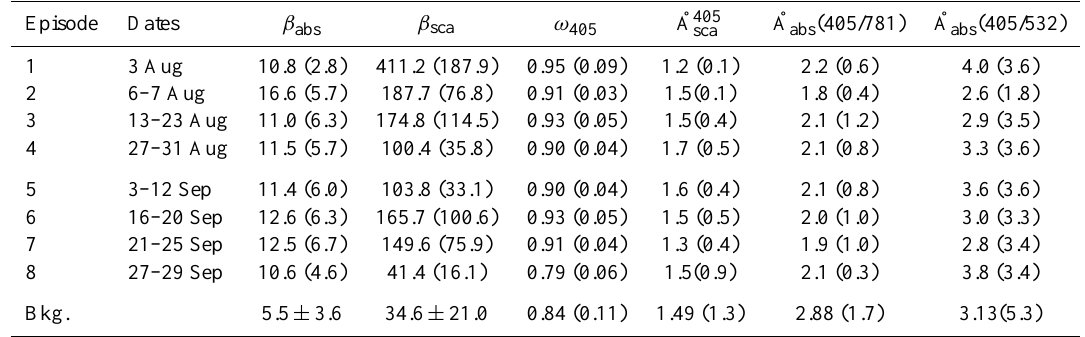
Table 1. Aerosol absorption and scattering coefficients at 405nm, ω 405 , ˚A 405 sca , ˚Angstrom exponents of absorption, with 1 σ standard devi- ations in parenthesis observed for pollution episodes and background periods during the 2008 CAPMEX field campaign. The background data is taken during the CAPMEX deployment when the Gosan Observatory was not experiencing one of the eight aerosol episodes. The statistics for the optical data are taken from 10min averaged signal from the